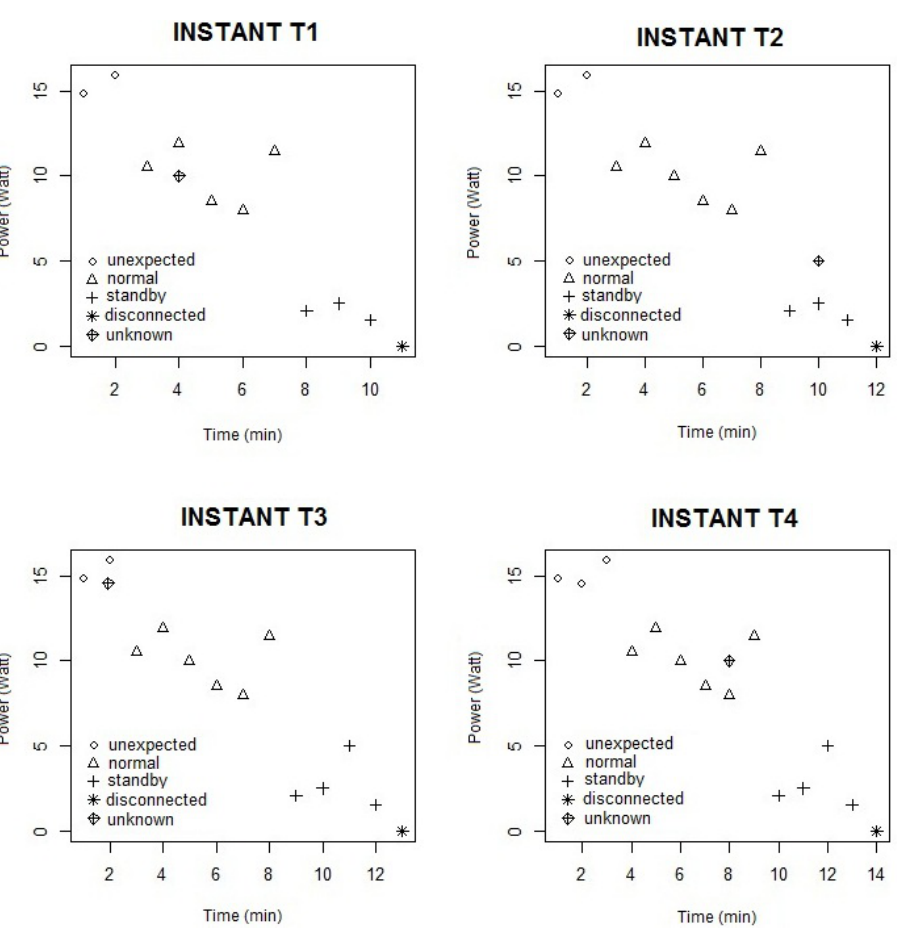
Figure 4. Example of the K-nearest neighbors (KNN)